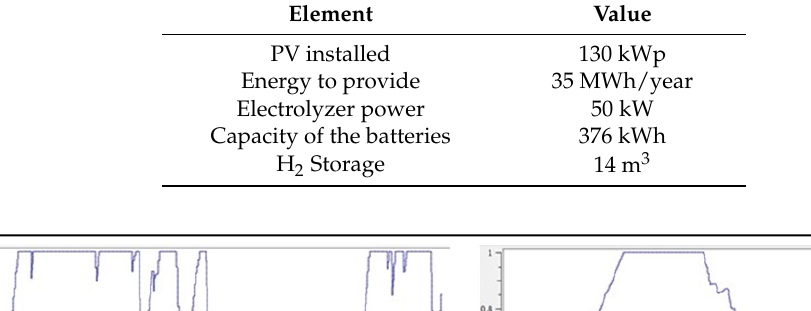
Table 6. Values of the most competitive scenario.